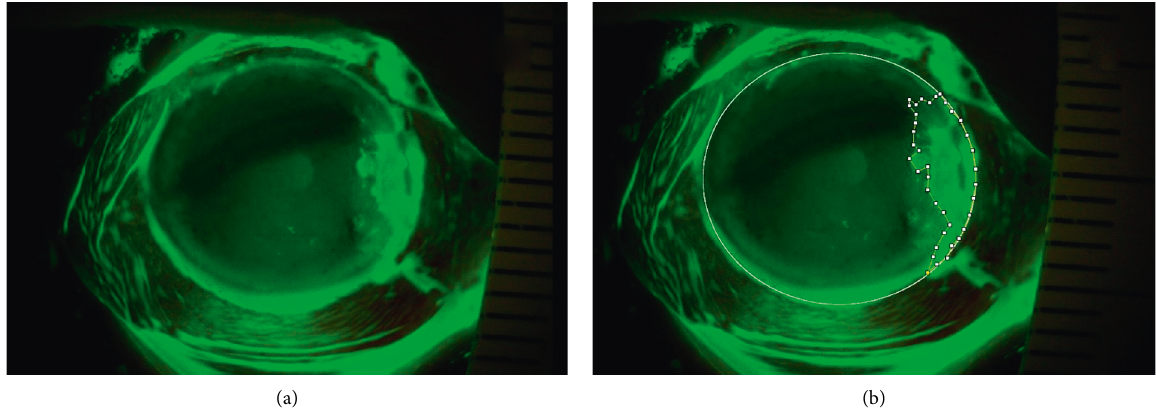
Figure 2: Photographs of the fluorescein-stained positive epithelial defect of the cornea after pterygium excision. (a) Original photo. (b) Photo after manual delineation of the fluorescein-stained positive corneal epithelial defect using ImageJ freeware.